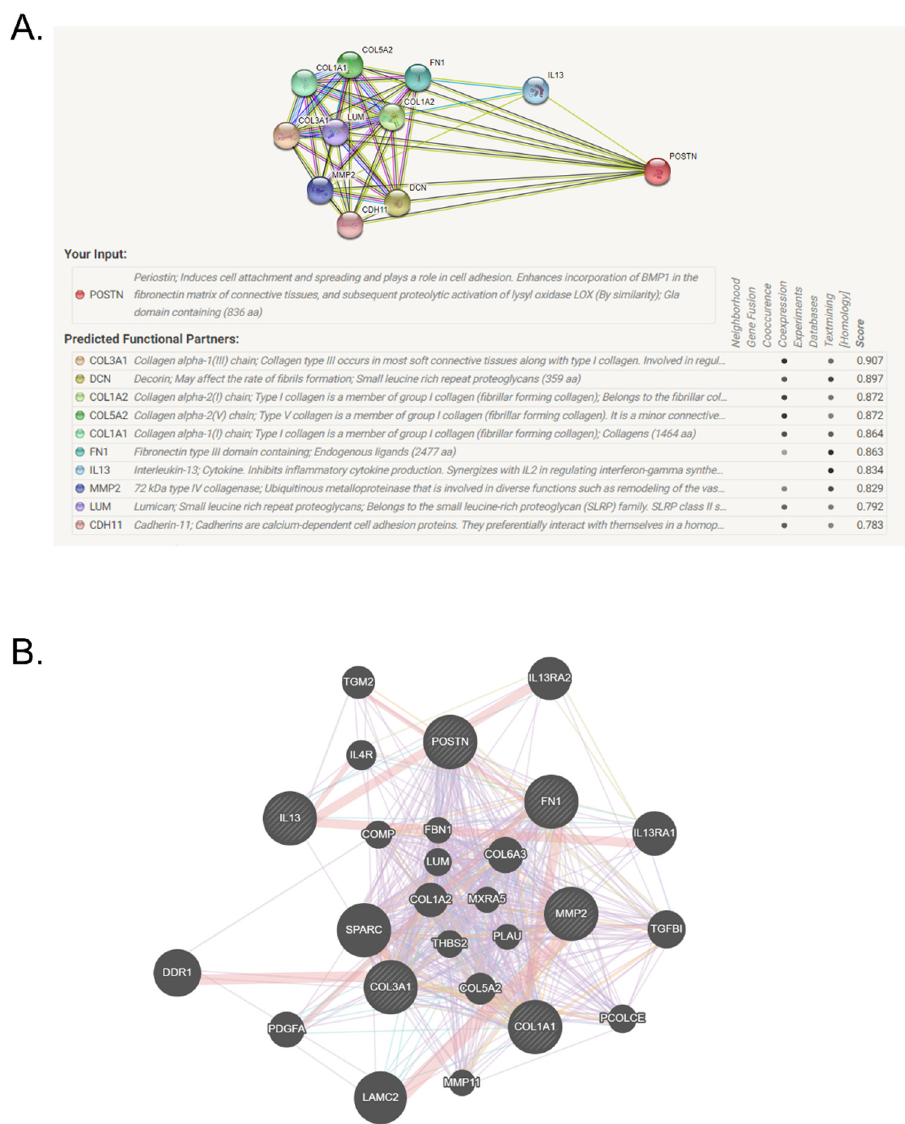
Figure 10. STRING network representing the predicted functional partners of POSTN. Predicted functional partners with POSTN ( A ). Network of POSTN and functional partners ( B